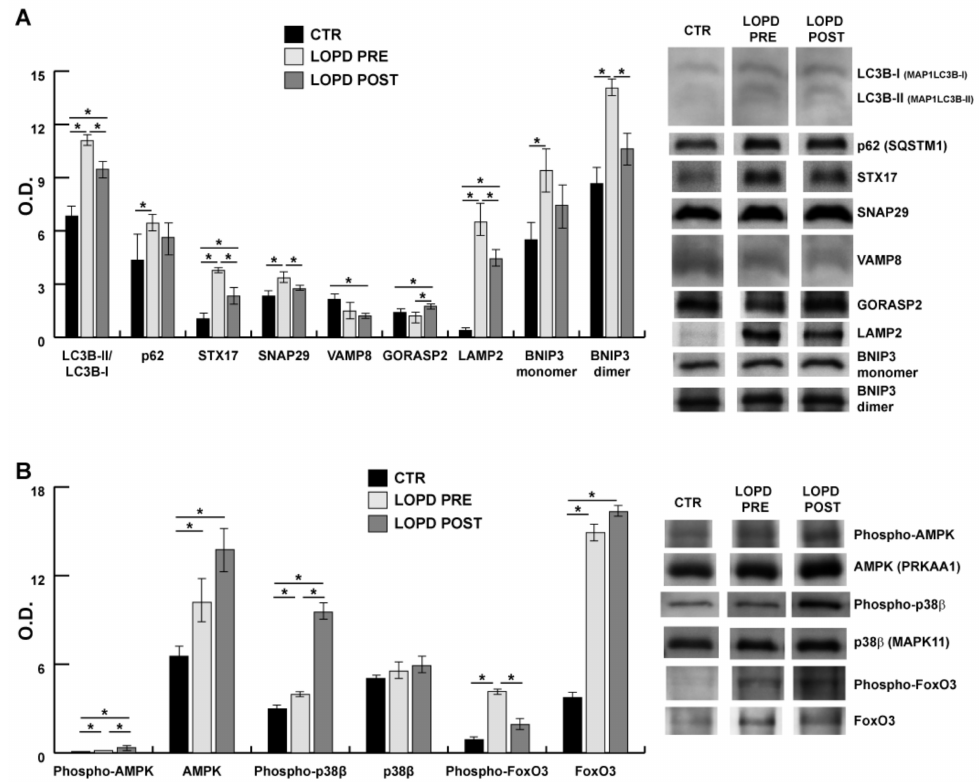
Figure 7. Lysosomal autophagy and apoptosis. Representative immunoblot images (cropped images) and histograms (mean ± SD) showing protein abundance of: ( A ) microtubule associated protein 1 light chain 3 beta (LC3B/MAP1LC3B), ubiquitin-binding protein p62/sequestosome 1 (p62/SQSTM1), sintaxin 17 (STX17), synaptosomal-associated protein 29 kDa (SNAP29), endobrevin (VAMP8), Golgi reassembly-stacking protein 2 (GORASP2), lysosome-associated membrane protein 2 (LAMP2), BCL2/adenovirus E1B 19 kDa protein-interacting protein 3 (BNIP3) in CTR, pre- and post-ERT LOPD; and ( B ) protein kinase AMP-activated catalytic subunit alpha 1 (AMPK/PRKKA1), p38 mitogen-activated protein kinases 11 (p38 β /MAPK11), and fork head box O3 (FoxO3) in CTR, LOPD PRE and LOPD POST. The data were normalized against the total amount of loaded proteins stained with Sypro Ruby. Statistical analysis was performed by ANOVA and Tukey’s test (* p < 0.05). Blot images have been cropped for a better visualization, full-length images are available in Supplementary Material (Figure S2). O.D. = optical